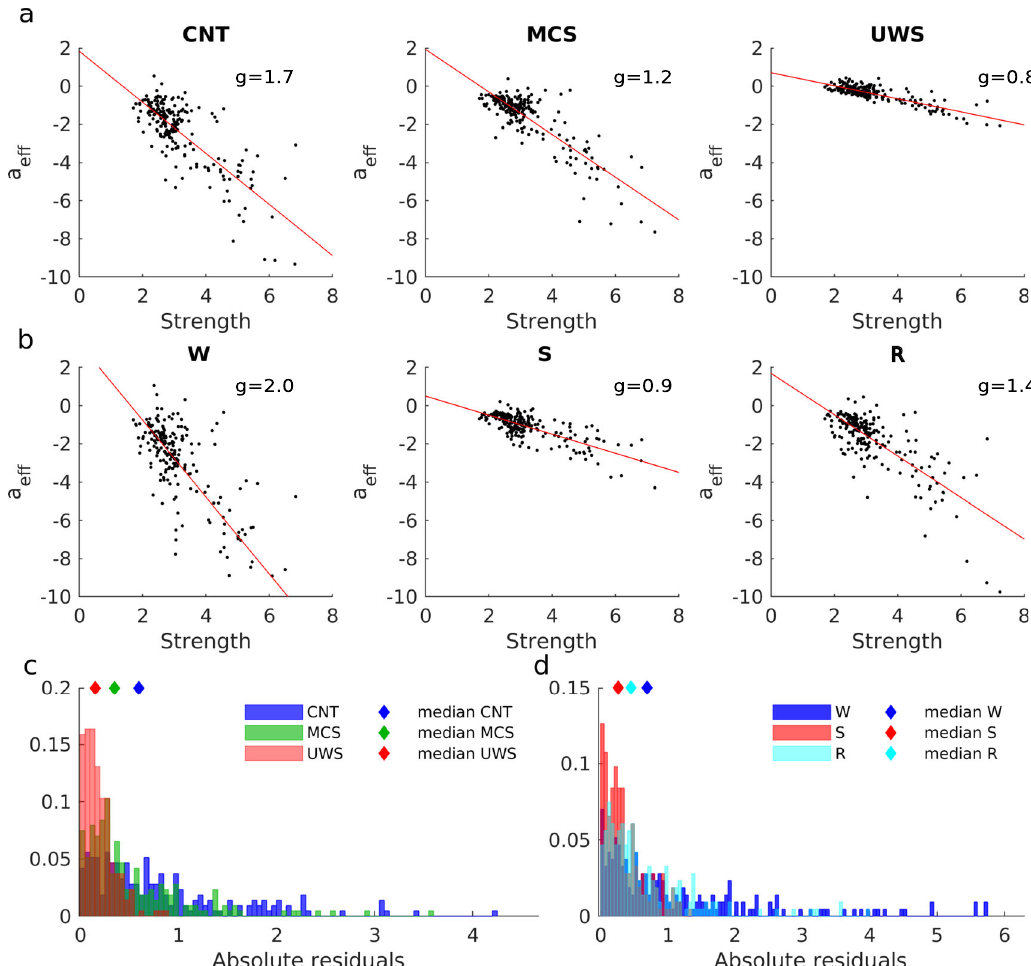
, were estimated j were optimized, after fi xing g to that obtained for the homogeneous model (see j j , for healthy controls and DOC patients ( a ) and for awake and and the estimated linear relationship between a eff and S j , for each group. d Same as ( c ) but j j